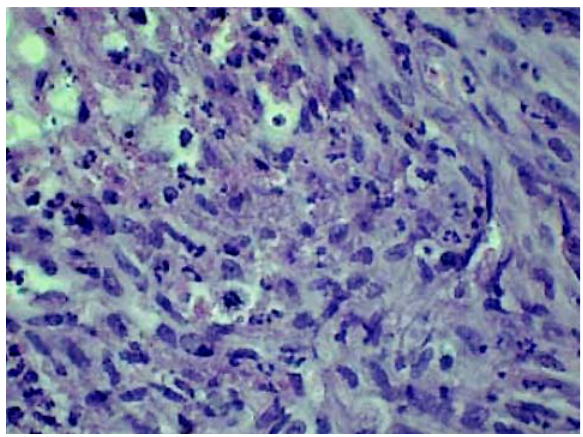
Figure 2 – Mitoses < 6/HPF and the tumor lacked necrosis